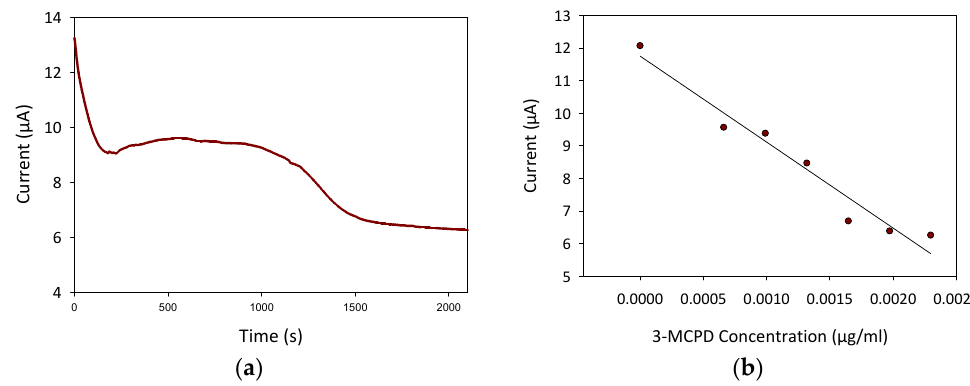
Figure 5. ( a ) Amperometric curves of ABS, ABS-G, and ABS-G with electrodeposited ZVI; ( b ) calibration plot of current measured versus 3-MCPD concentration ( R 2 = 0.9539). Table 1. Comparison between electrochemical 3-MCPD sensors based on past reports.